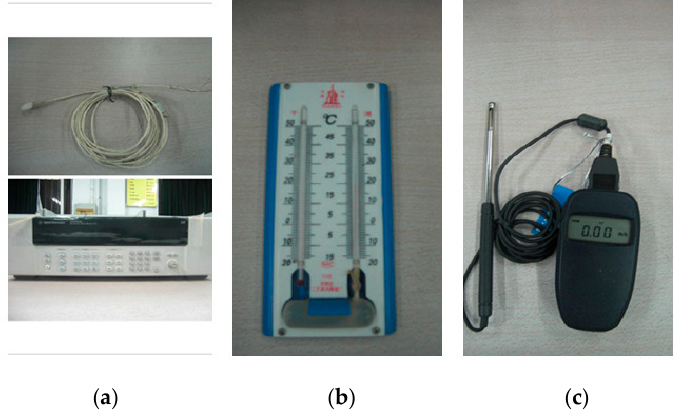
Figure 2. The test instruments of thermal environment: ( a ) Temperature data acquisition (Agilent34980A); ( b ) Dry-wet bulb thermometer (TJ-103); and, ( c ) Thermal anemometer. A total of two conditions are conducted, and each experiment temperature is controlled at 3 levels. Among them, winter is 16 °C, 22 °C, 24 °C, summer is 22 °C, 25 °C, 28 °C. When the body is warm and comfortable, fully dressed in a quiet state, 18 °C is not sense of coldness and 15 °C is the apparent temperature limits of the coldness, according to the research results of the relevant health departments at home and abroad. In this study, we discuss the comfort zone of thermal environment, and also study whether the comfort of each environment can compensate for other environment. Therefore, a lower 16 °C is set as a reference for comparison. The thermal resistance clothing is about 1.5 clo and 1.02 clo in winter and summer. Participants are asked to sit still for 30 min, followed by an experiment and a subjective questionnaire. Evaluation content is not allowed during experiment. The duration of each temperature level is controlled by 30 min. The former15 min is the adaptation process in each case, and the individual information in the questionnaire is filled at that time. The middle 10 min participants fill out questionnaires, and the experimental organizers need to record all parameters. The last 5 min is the parameter adjustment phase. There are many factors that affect the thermal comfort. The operative temperature reflect the comprehensive effect of convection and radiation. Therefore, it has certain accuracy and described the thermal comfort of indoor environment with the operative temperature under most indoor conditions [26]. The operative temperature is calculated in accordance with Equation (2). Participants’ thermal comfort evaluation vote (TCEV) is recorded correspondingly.